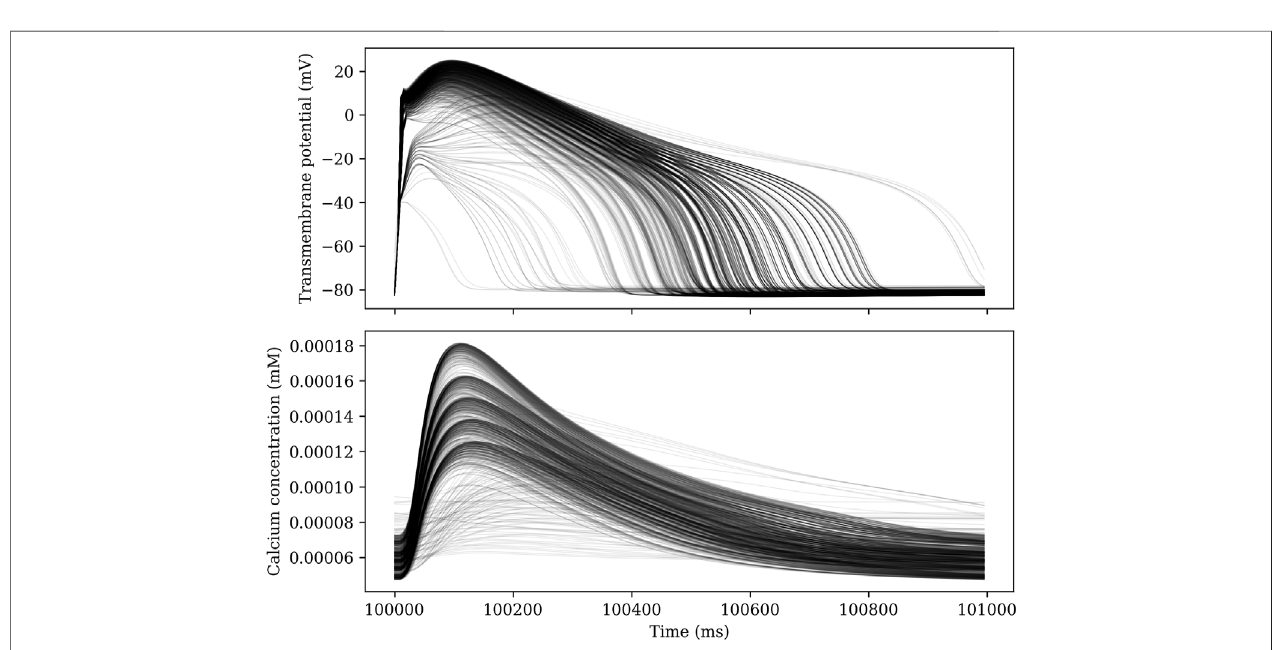
FIGURE 2 | Traces of the transmembrane potential and calcium concentration for 1000 different sets of parameters in an ensemble simulation.